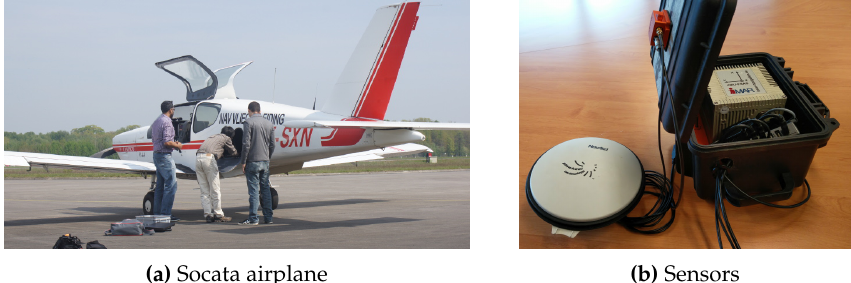
Figure 3. Socata airplane and sensors used for data collection.